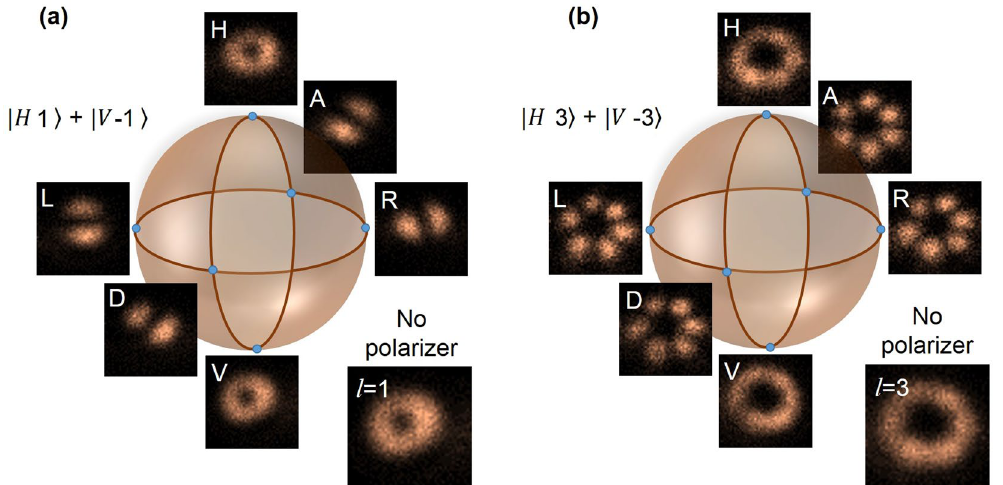
Figure 4. Gallery of images representing the probability distribution of the heralded signal photons. Depending on the polarization of the idler photon projected (white letters in the images) at different points in the polarization Poincaré sphere, the spatial distribution of the heralded signal change into different mode patterns in the LG-Bloch sphere. The sequence of coincidence images of the heralded signal due to particular polarization of its partner (idler) photon while pumping with non-separable states of ( a ) first order, and ( b ) third order LG modes around the meridian (vertical circle) and the equator (horizontal circle) in the LG-Bloch sphere confirms the generation of hybrid entangled two photon states encoded in polarization and OAM. In absence of any polarizer in the path of the idler photon, the spatial distribution of the heralded signal photon (inset) shows a statistical mixture of all states of the LG-Bloch